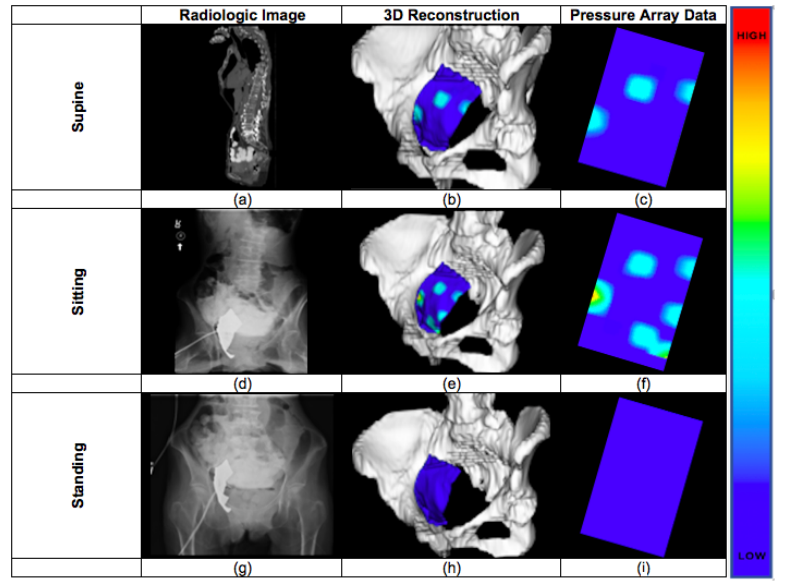
Figure 1. Examples of the body position radiology data with three-dimensional reconstructions of the bones of the pelvis with the pressure array data. ( a , d , g ) Radiological images of the cadaver with the pressure sensor implanted in supine, sitting and standing positions. ( b , e , h ) 3D reconstructions of the lumbar and pelvic bones with the pressure sensor mapping along the pelvic floor. ( c , f , i ) Images of the pressure array data taken without 3D reconstruction. The higher the pressure the more red the color, while the lower the pressure the more blue the color on the